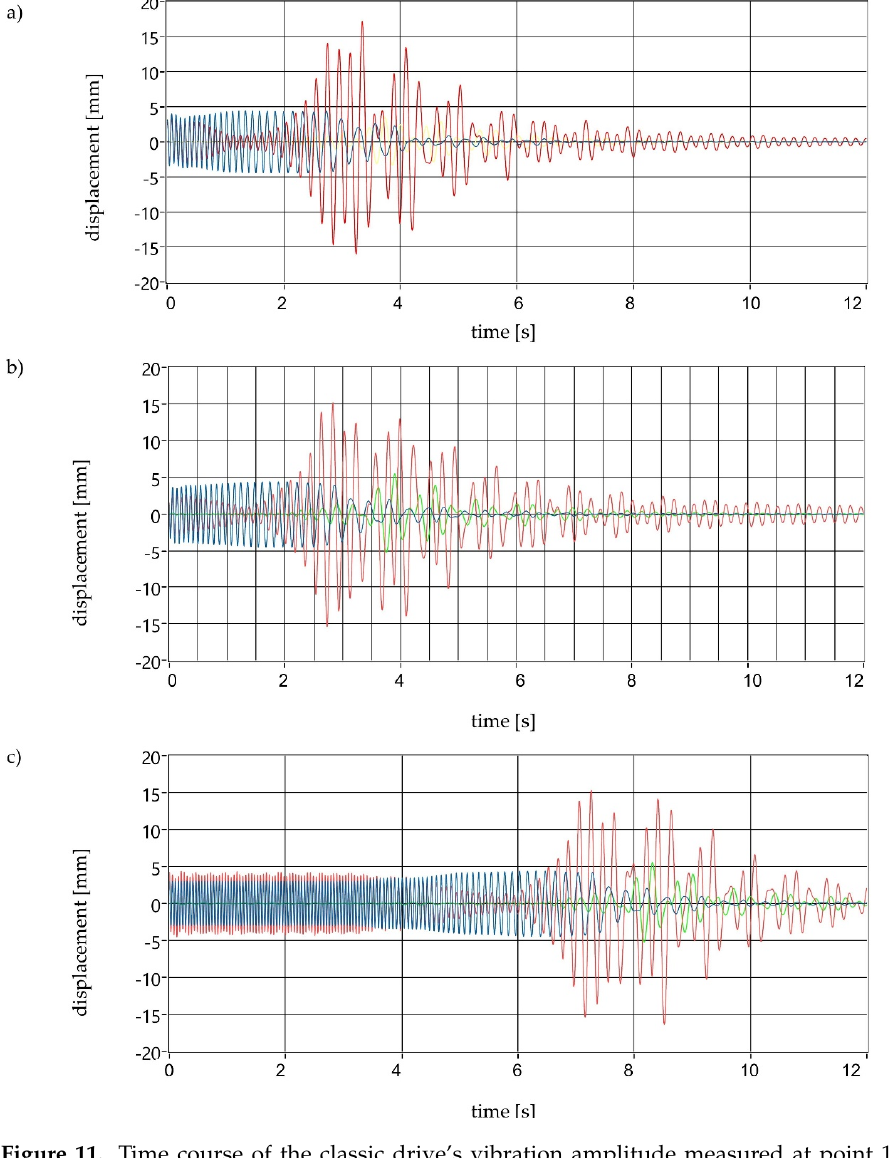
Figure 11. Time course of the classic drive’s vibration amplitude measured at point 1L versus time (y direction—red, x—blue, z—green) during braking for the rated frequency: ( a ) f = 13.2 Hz; ( b ) f = 16.5 Hz; ( c ) f = 19.8 Hz.